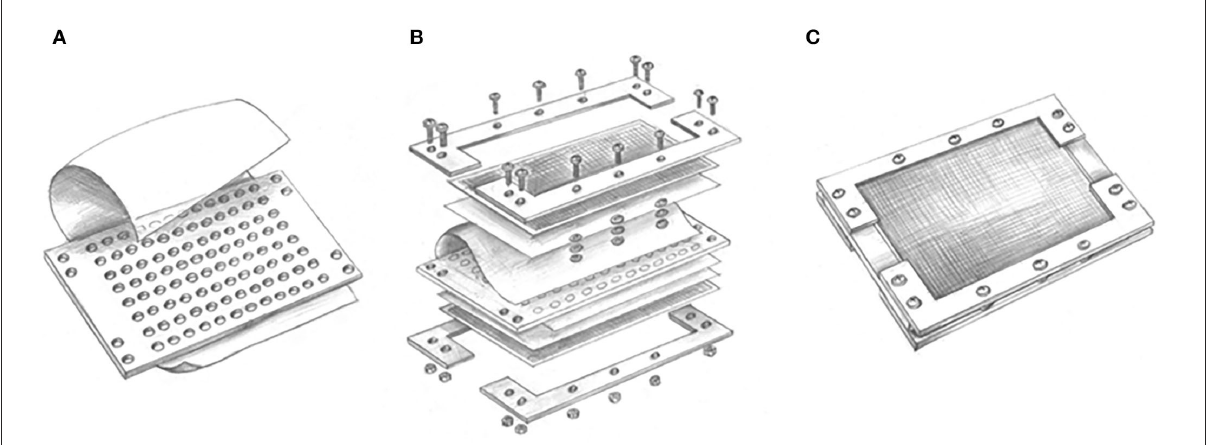
FIGURE1 Conceptual design of modified ichip device: (A) A central plate including 96 through holes has added a suspension containing microbial cells in each hole and glued with the polycarbonate membranes by silicon glue; (B) nylon mesh and stainless steel mesh are, respectively, added on both sides of the plate, which are fixed with splints and screws; and (C) the assembled modified ichip device can be cultivated in situ